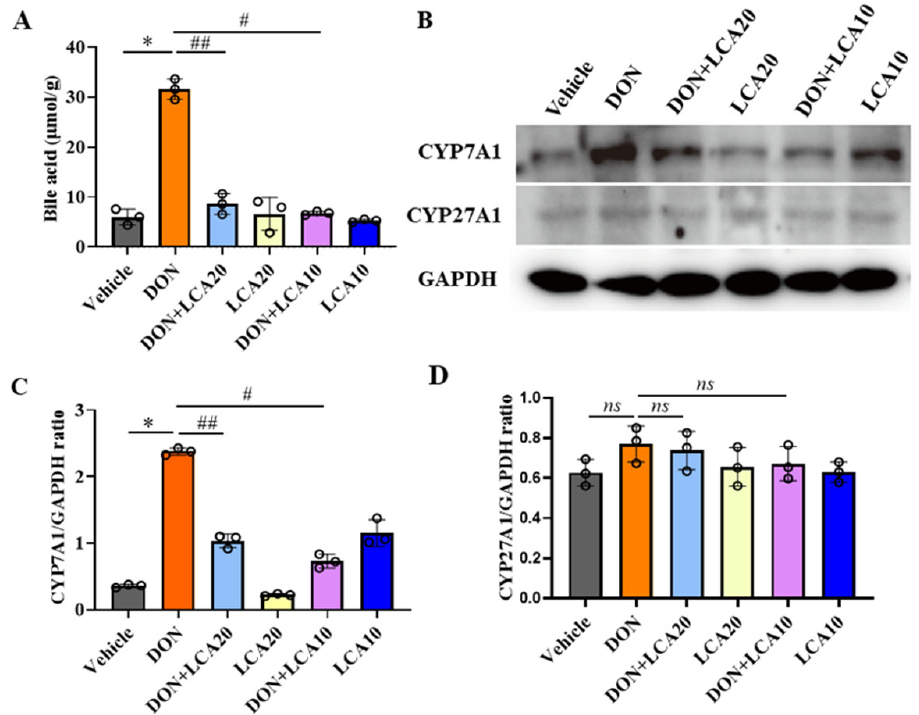
Figure 4. LCA reduces DON-increased bile acids in IPI-2I cells. ( A ) Bile acid levels measurement in IPI-2I with indicated treatments. ( B ) Western blot detected the expression of CYP7A1, CYP27A1, and GAPDH protein. ( C ) The relative expression levels of CYP7A1 were determined by GAPDH standardization. ( D ) The relative expression levels of CYP27A1 were determined by GAPDH standardization. Results are mean ± SD. n = 3. * represents DON group vs. vehicle group p < 0.05. # represents DON + LCA10 group vs. DON group p < 0.05. ## represents DON + LCA20 group vs. DON group p < 0.05. ns represents no significant difference between the two groups.